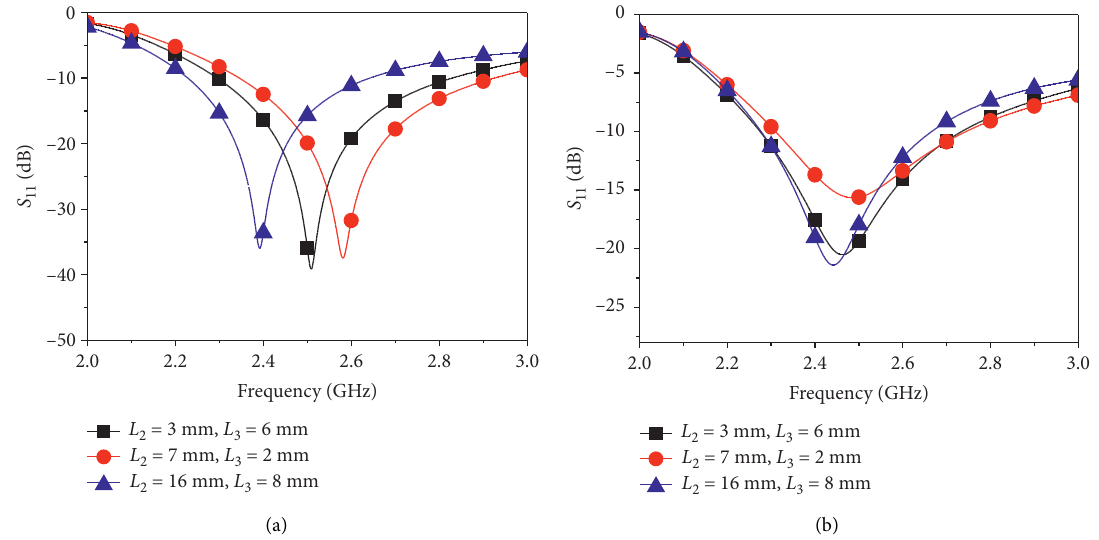
Figure 5: Variation of S 11 versus resonant frequency of different parameters. (a) Straight arms. (b) Bent